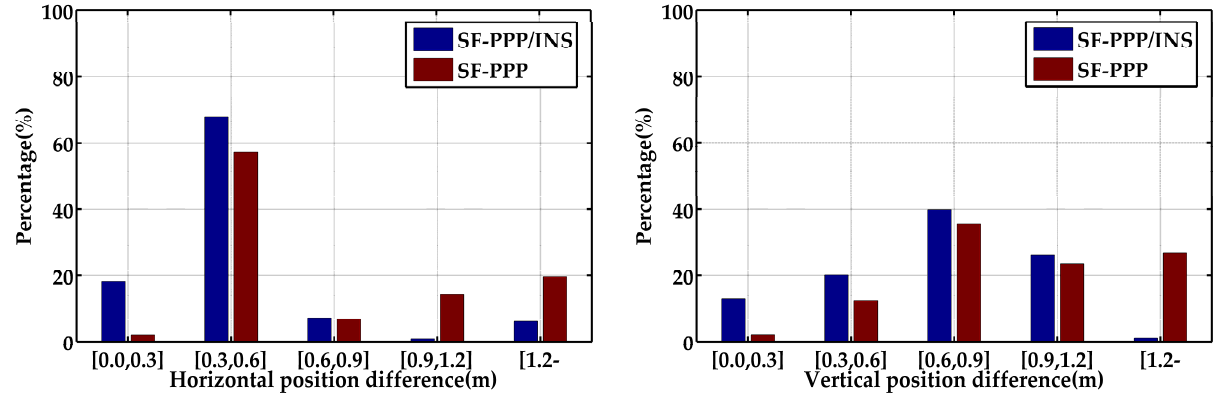
Figure 5. Distribution of position differences of G + B SF-PPP and G + B SF-PPP/INS tight integration in the horizontal direction ( left ) and vertical direction ( right ). Table 2. RMS of position differences in the three directions of SF-PPP and SF-PPP/INS tight integration.